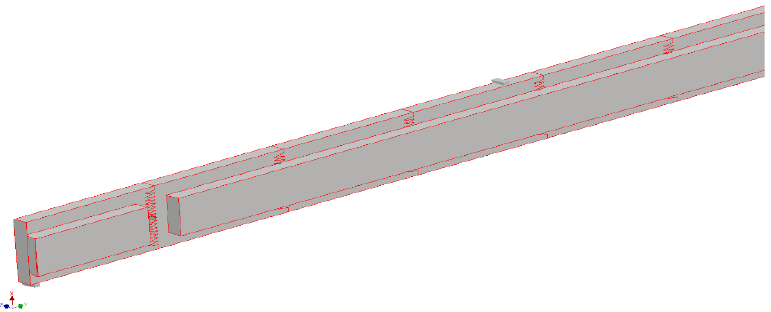
Figure 2. Fragment of the selected geometric model of the continuous long frame version B made of glued material with a finger-jointed lamella length of 200 mm.